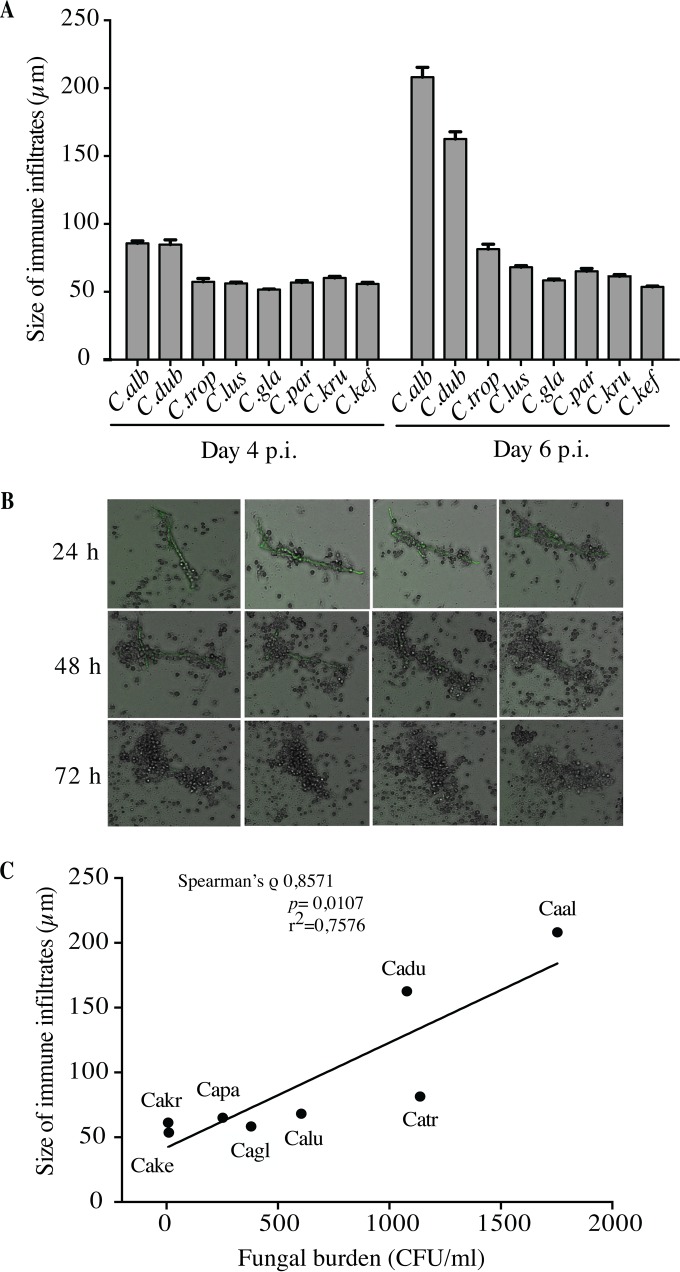
Dynamics of immune infiltrate size according to Candida species. (A) Human mononuclear and polymorphonuclear peripheral blood cells from donors were infected with Candida spp. for up to 6 days. The size of immune infiltrates was measured by light microscopy on days 4 and 6 postinfection. The data are presented as the mean + SEM of structure sizes from 10 subjects for 32 clinical isolates of Candida species 6 days postinfection. (B) Coculture analysis by time-lapse video imaging. Human peripheral blood mononuclear and polymorphonuclear cells were infected with C. albicans cells at an MOI of 2,000:1. Cell aggregation was followed for 72 h, and a capture was done every 10 min. Bars represent 50 μm. (C) Pairwise correlation of immune infiltrates size and fungal burden. Shown is a graphical representation of the fungal burden means (x axis) and immune infiltrate size (y axis) 6 days postinfection. The line indicates the slope.